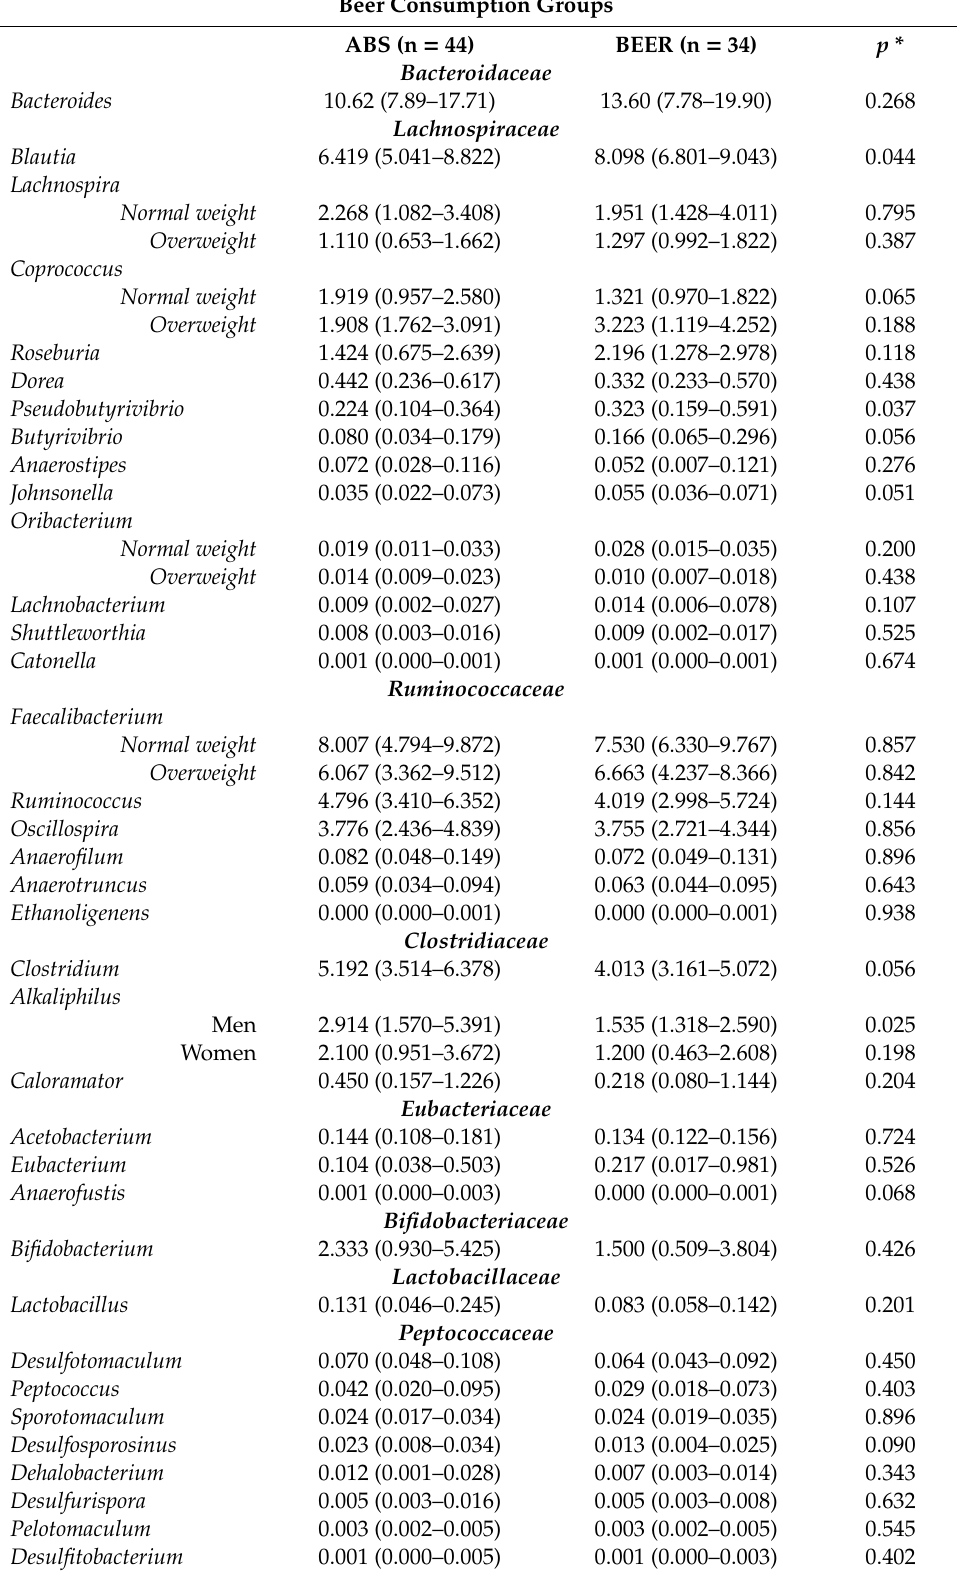
Table 3. Relative abundances [%] of bacterial genera in moderate beer consumers and